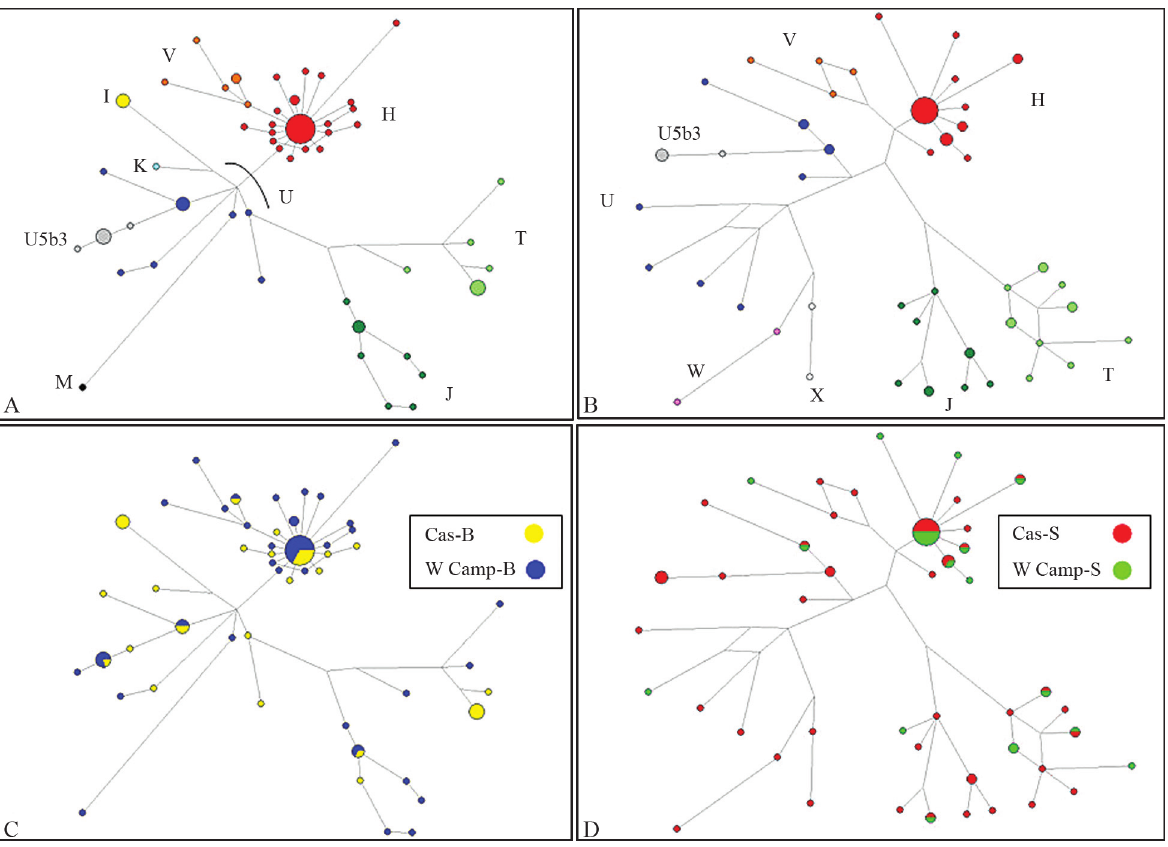
Figure 3 - Networks obtained from combined dataset (control region and coding region) for MBU (A and C) and STD (B and D) strategies. A and B: phylogenetic relationships among mitochondrial haplogroups; C and D: geographic distribution of mitochondrial haplogroups. Cas: Cabras; W Camp: western Campidano; B: MBU method; S: STD